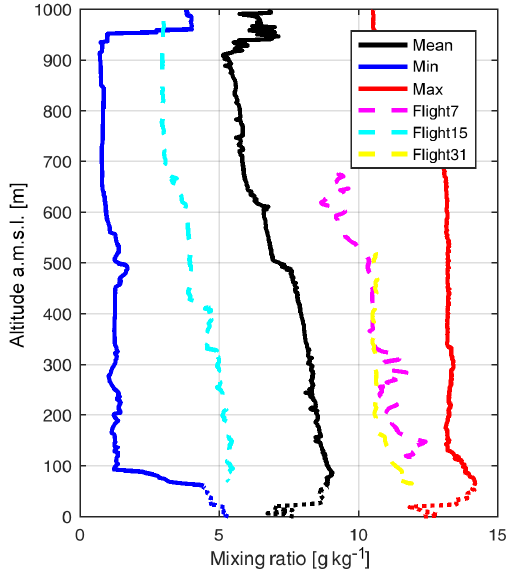
Figure 9. Average profile of water vapour mixing ratio (black) and range of mixing ratio (minimum: blue; maximum: red) encountered during the 41 WIPAFF measurement flights. Additionally, the av- eraged profiles of flight 7 (magenta), flight 15 (cyan) and flight 31 (yellow) are included. As altitudes below 60m altitude were only performed during take-off and landing, i.e. above land and not above the North Sea, the profiles are provided as dotted lines.